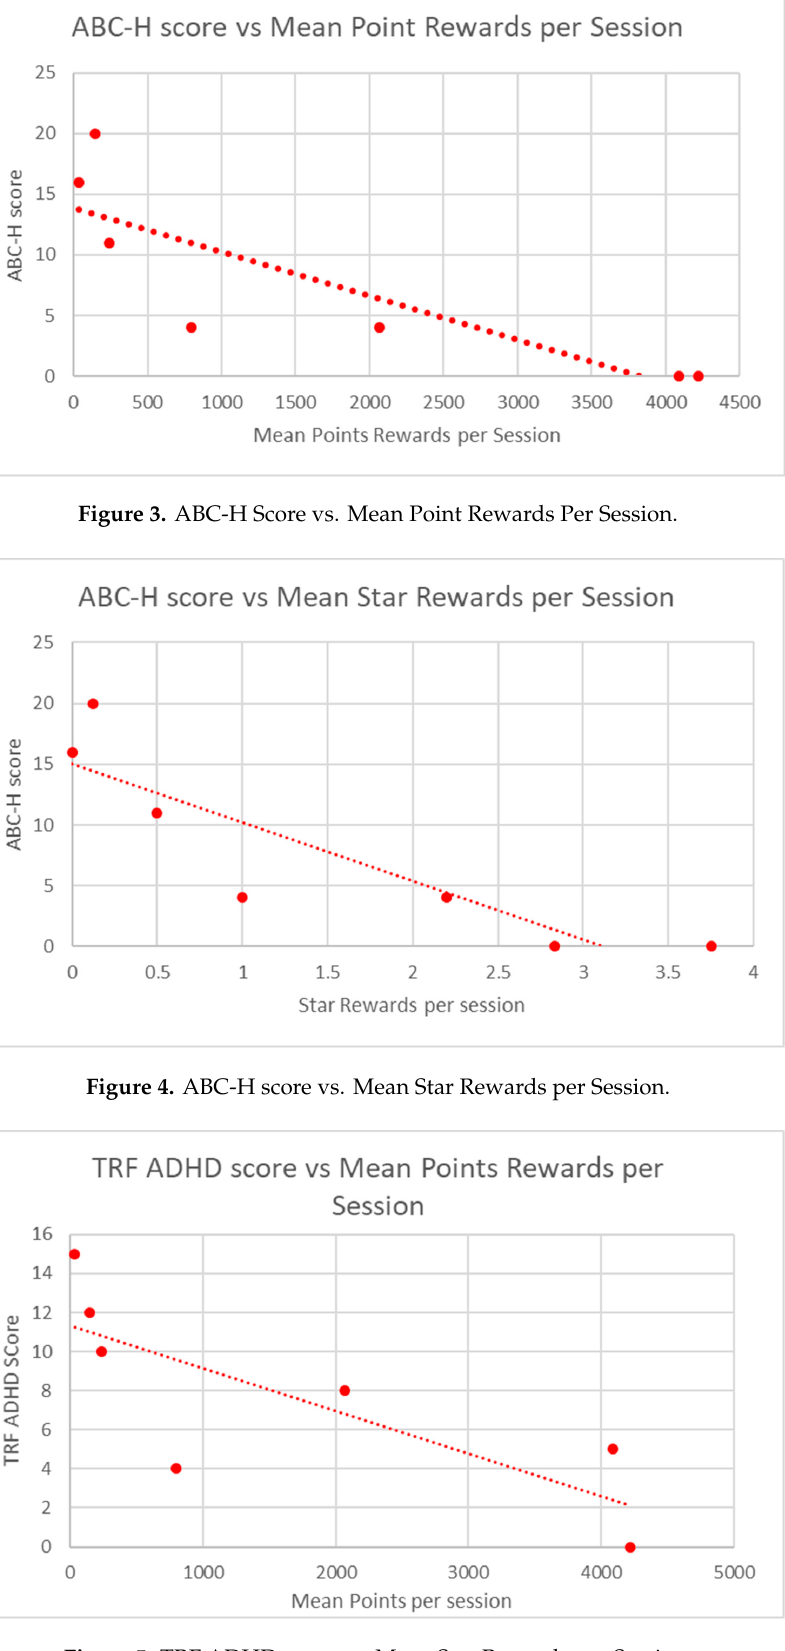
Figure 5. TRF ADHD score vs Mean Star Rewards per Session. 4. Discussion New technologies may herald novel ways of identifying and characterizing symptoms of ADHD in student populations. Over 6.4 million children and adolescents in the US have been diagnosed with ADHD [46], and the condition currently impacts over 10 million US adults [47]. Despite this, research suggests that ADHD symptoms continue to be under-recognized despite leading to adverse educational and health outcomes. Technology may allow for a highly scalable and objective assessment of ADHD symptoms. While technology could augment traditional subjective approaches, its utility and ecological validity must be assessed. This study provides supportive evidence that Empowered Brain is a technology that can be used by students and teachers within a regular classroom setting. The usability of this system was demonstrated despite methodologically-imposed limitations designed to ensure high ecologically validity. These limitations include student use of the technology, as facilitated by their own regular teachers, during their regular lessons/school day, and within their own classrooms. No additional time, staff, or fiscal resources were provided except for initial teacher training. The study